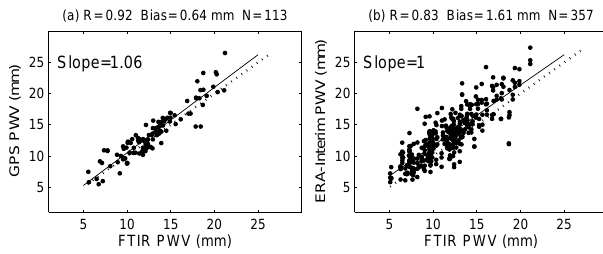
Figure 7. Comparison of GPS-derived and ERA-Interim reanalysis PWV with coincident FTIR